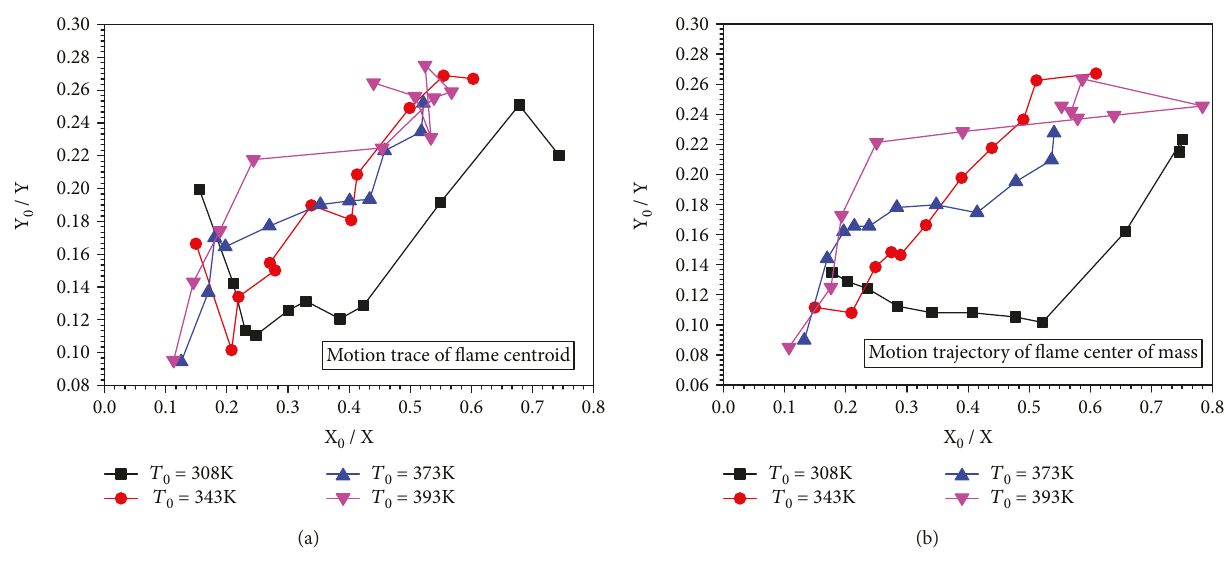
Figure 10: Motion trajectory of fl ame